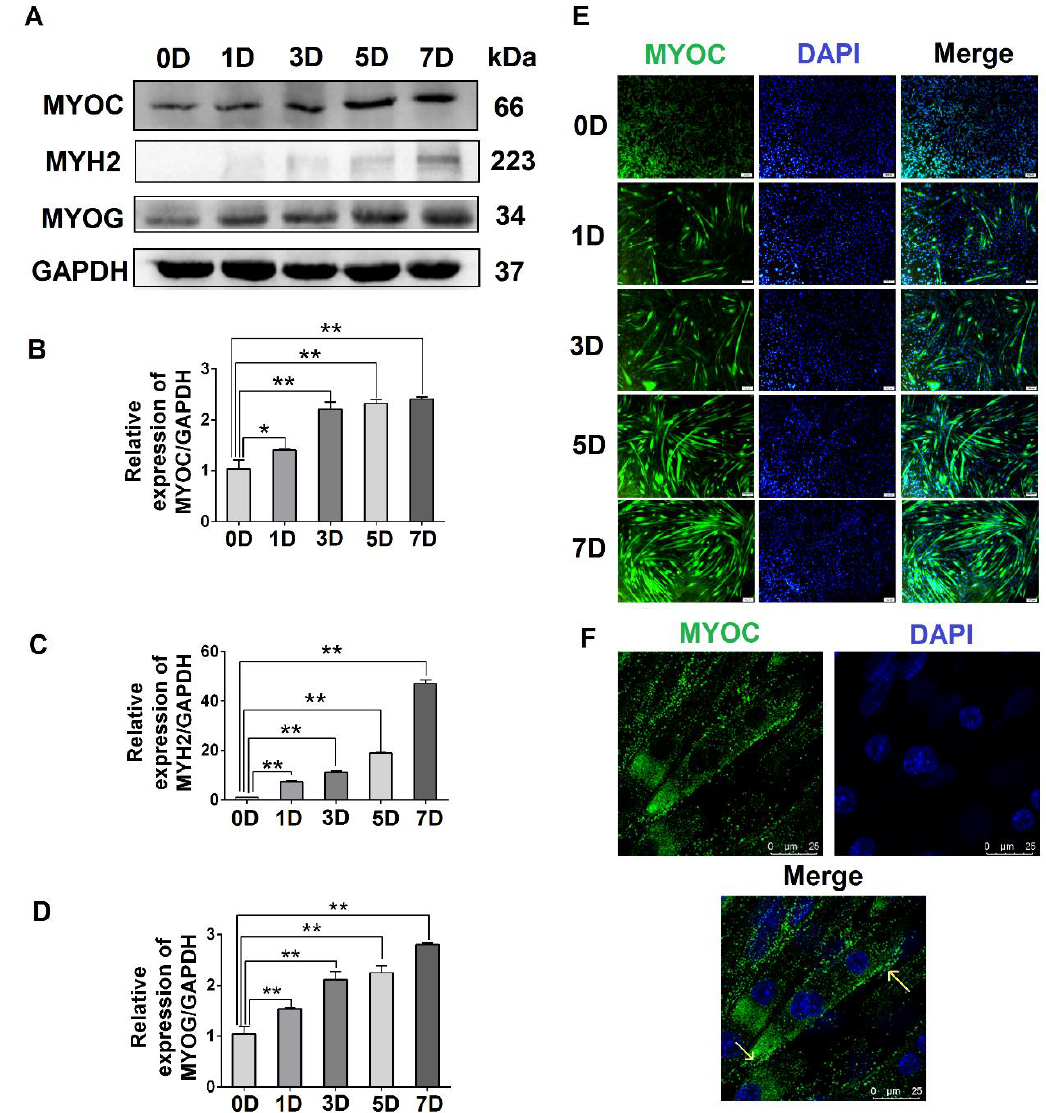
Figure 1. The effect of differentiation on MYOC levels and its localization in C2C12 cells. ( A ). Change in MYOC, MYH2, and MYOG expression levels during C2C12 cell differentiation. ( B ). Gray scanning of MYOC in Figure A. ( C ). Gray-level scanning of MYH2 in Figure A. ( D ). Gray scanning of MYOG in Figure A. ( E ). Immunofluorescence was used to measure changes in MYOC expression and the size and length of myotubes during the differentiation of C2C12 cells. ( F ). MYOC was labeled green with FITC, while the nucleus was stained blue with DAPI. MYOC was principally located on the cell membrane during the differentiation of C2C12 cells, as identified by laser confocal detection. (** p values < 0.01, * p values < 0.05) ( n = 3).